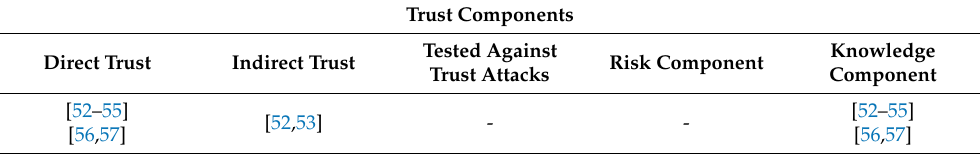
Table 4. Research on trust in substation categorized by trust